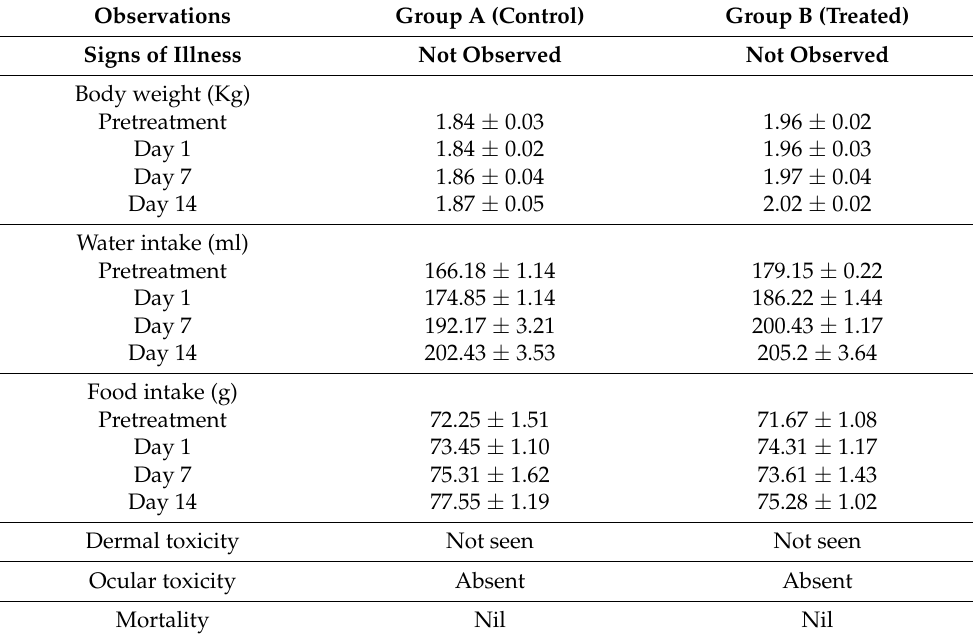
Table 3. Clinical findings during acute oral toxicity